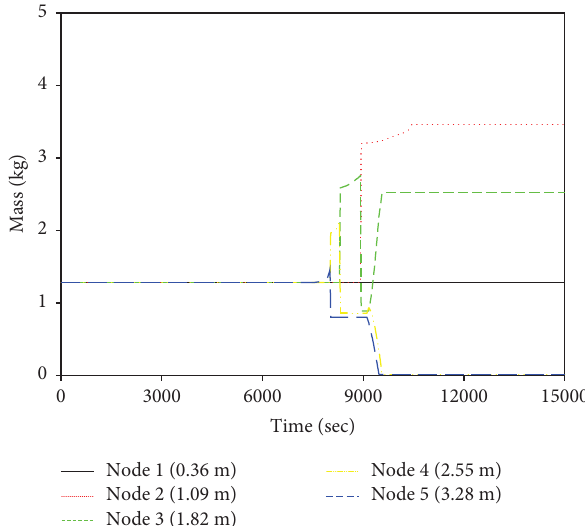
Figure 9: CINEMA results on fuel cladding mass in TMI-2 severe